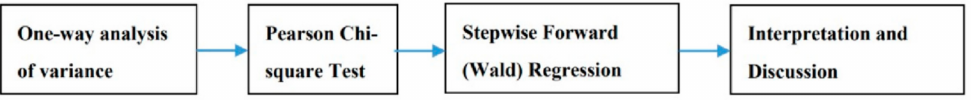
Figure 4. The flow of data analysis and modelling